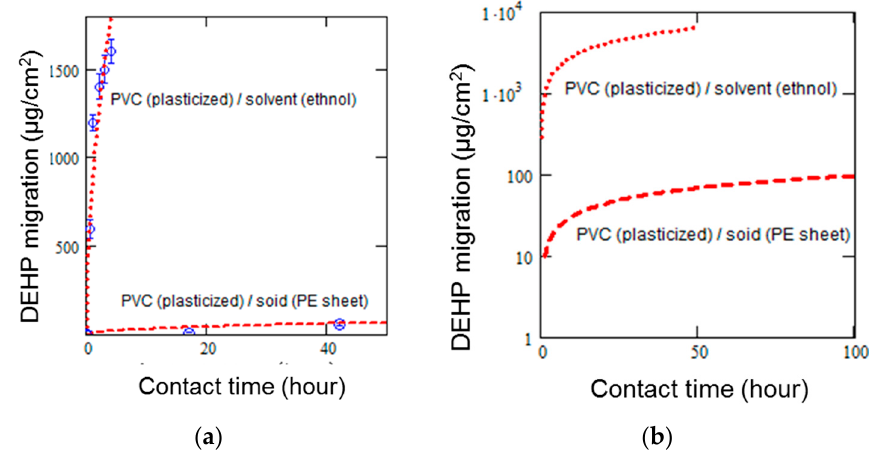
Figure 4. The difference in DEHP’s migration from PVC to solvent (ethanol) and solid (PE sheet); ( a ) comparison of DEHP’s migration and ( b ) extrapolated estimation of migration by the Fickian model. The error bars represent one standard deviation of the three measurements.